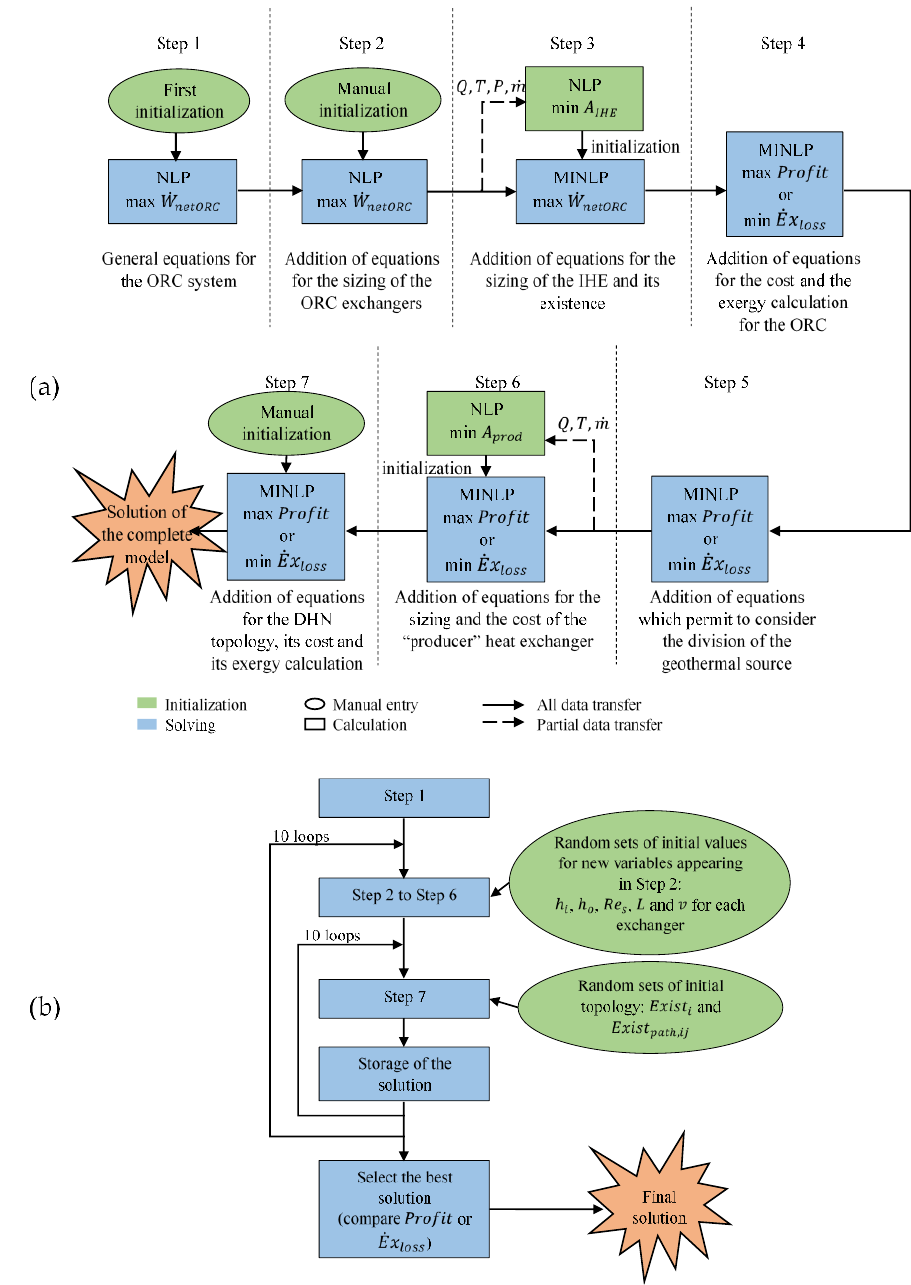
Figure 3. Solution strategy: ( a ) summarize of steps, ( b ) algorithm in order to find a confidence solution